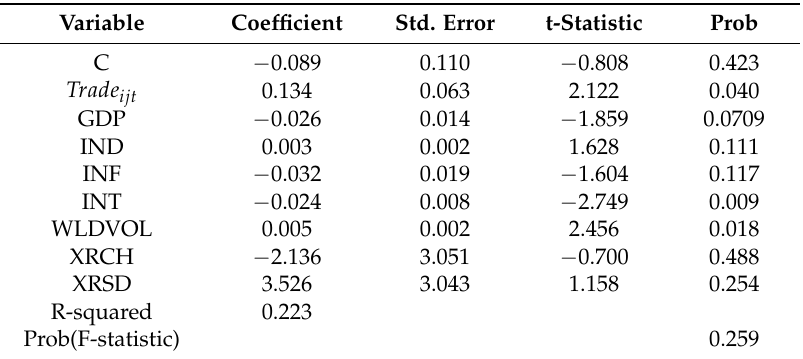
Table 6. Determinant of Stock Market Co-movement between Pakistan and India. Variable Coefficient Std.